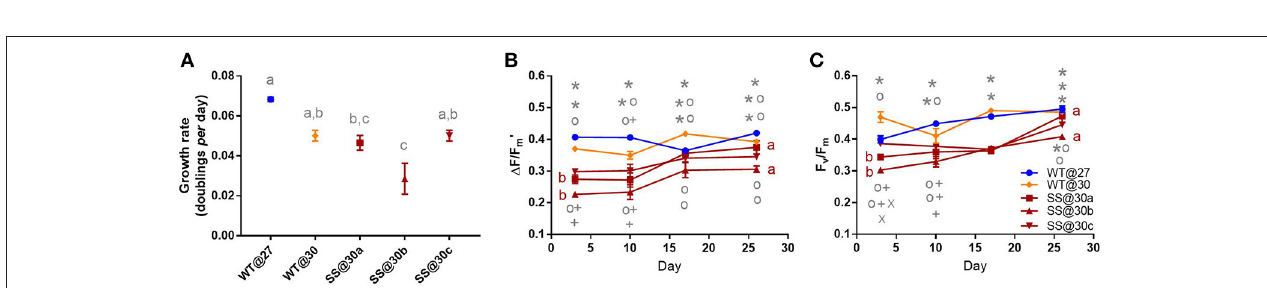
FIGURE 3 | Symbiodinium D1. Results of transplant experiment; comparison of mean ( ± SEM) growth rates (A) , effective quantum yields (B) and maximum quantum yields (C) between the wild-type (WT) Symbiodinium type D1 population at 27 ◦ C (WT@27), WT transferred into 30 ◦ C (WT@30) and the three selected Symbiodinium D1 populations (SS@30a, b, c). Populations’ were pre-acclimated for 14 days and growth rates were measured following 17 more days and quantum yield measurements over the following 26 days. Statistically significant differences among populations at a given time point are represented by different letters (A) or symbols above/below the mean points (B,C) . Statistically significant differences over time (between D3 and D26) are represented by different letters ( B,C , Tukey’s post-hoc tests; P < 0.05), n = 3 for all means. Where error bars are not visible, they are small and hidden by the